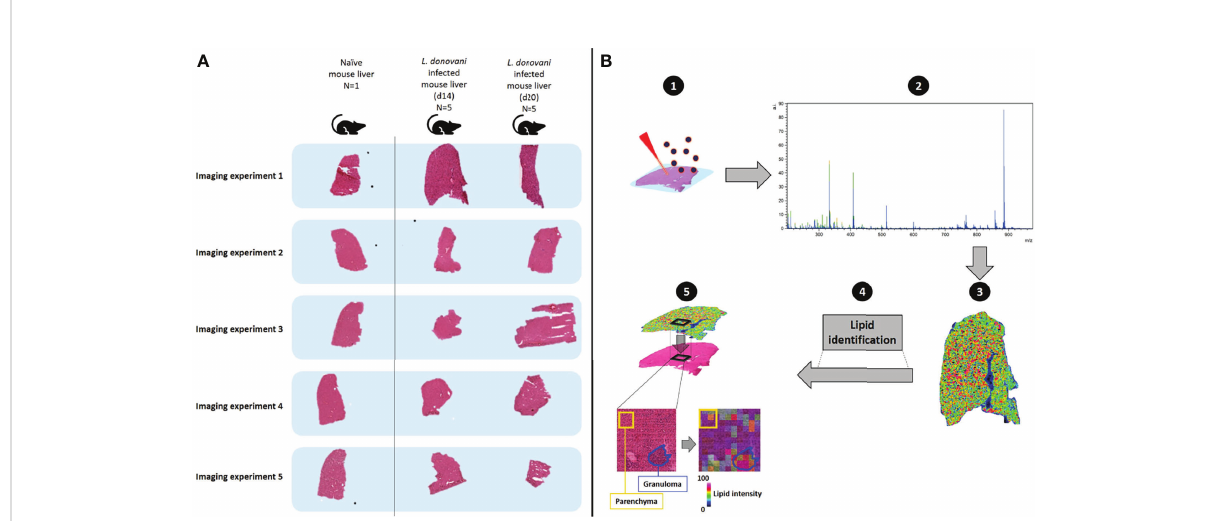
FIGURE 1 Schematic describing work fl ow for monitoring spatially-resolved lipids during hepatic Leishmania donovani infection. (A) Livers were obtained from a naïve C57BL/6 mouse and from L. donovani -infected C57BL/6 mice at d14 and d20 p.i. (n=5 mice per time point). Samples were sequentially measured, using the naïve tissue as a baseline and comparator (n=1). In addition, consistency of naïve mouse livers (n=5) is shown in Figure S1. (B) The spatial distribution of lipids and their respective structural identi fi cation was assessed by MALDI-MSI (1): a chemical matrix was applied to the tissue surface – this absorbs lipids from the tissue while retaining spatial localization. Subsequently, lipids were ionized by MALDI, which generates charged ions in the gas-phase (2). A mass analyzer is used to determine the mass-to-charge ( m/z ) ratio of these ions from which (3) the ions can be visualized to reveal their spatial localization and relative abundance across the analyzed tissue (4). Structural identi fi cation of spatially- resolved lipids was performed by tandem mass spectrometry (5). H&E-stained tissues were co-registered with mass spectrometry images, to allow integration of molecular lipid information from annotated regions of interest ( i.e. granulomas and surrounding parenchyma) with